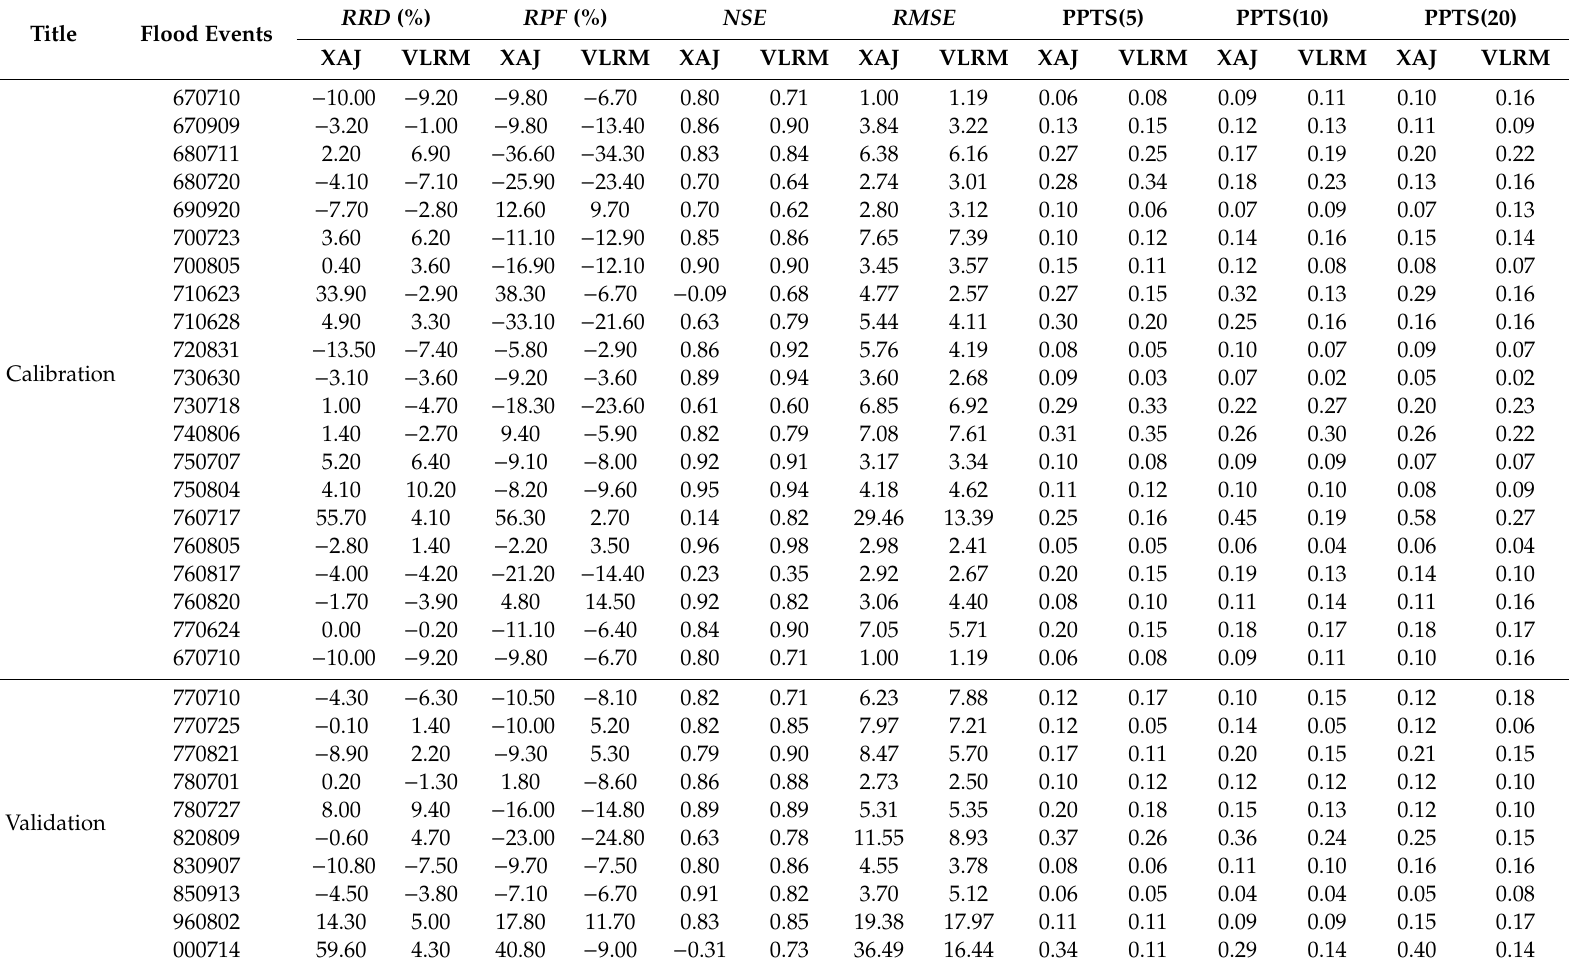
Table 3. Performance measures of XAJ and VLRM models in Xiuwu